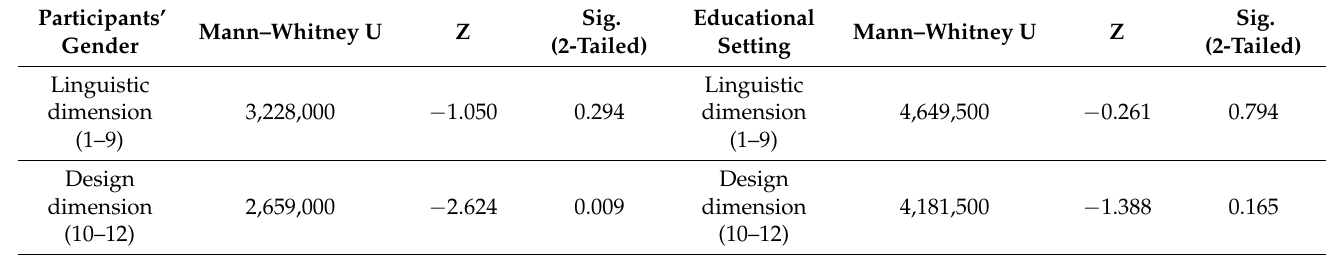
Table 6. Effect of gender and educational setting on the satisfaction results